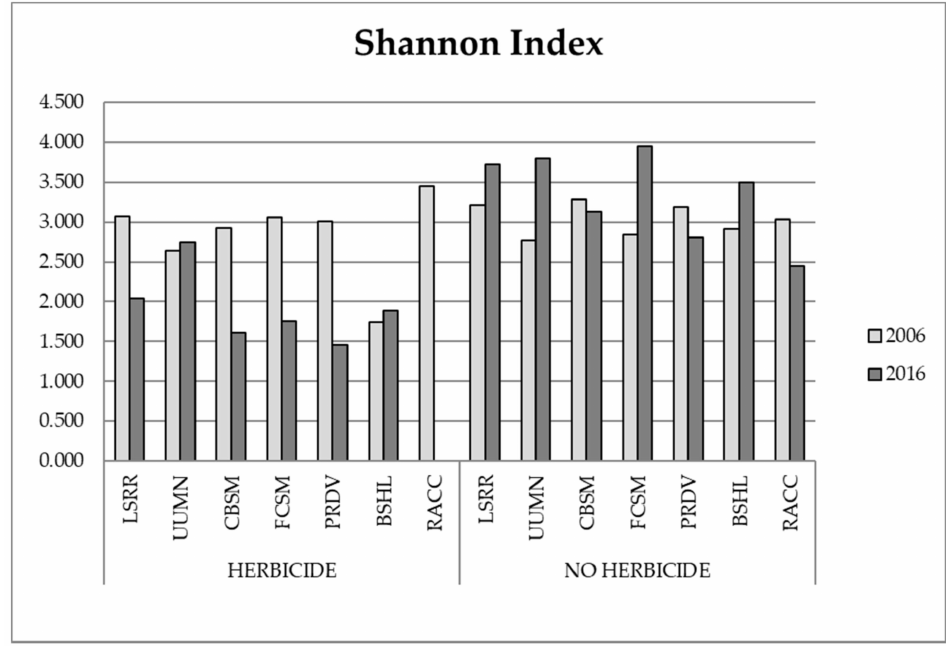
Figure 4. Assessment by the Shannon index for the plant communities in the herbaceous covers treated with and without herbicides in the two-time intervals (2006–2016).